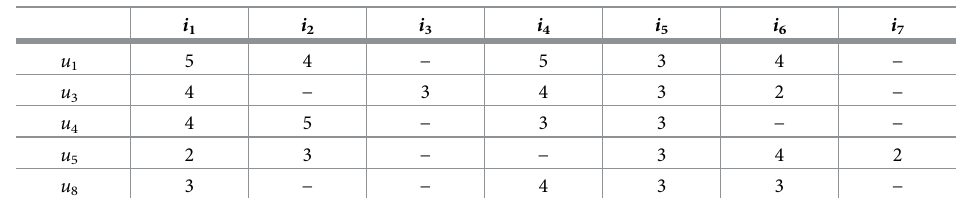
Table 9. Actual group members ratings.